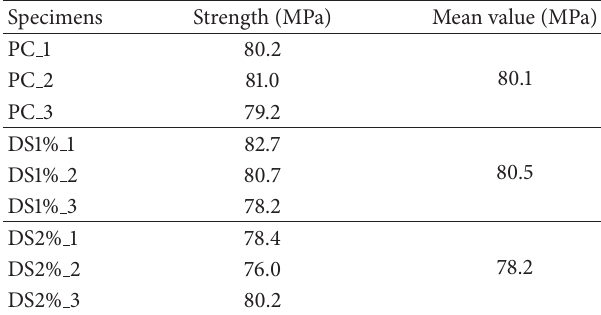
Figure 2: Four-point bending test. Table 2: Cube compressive